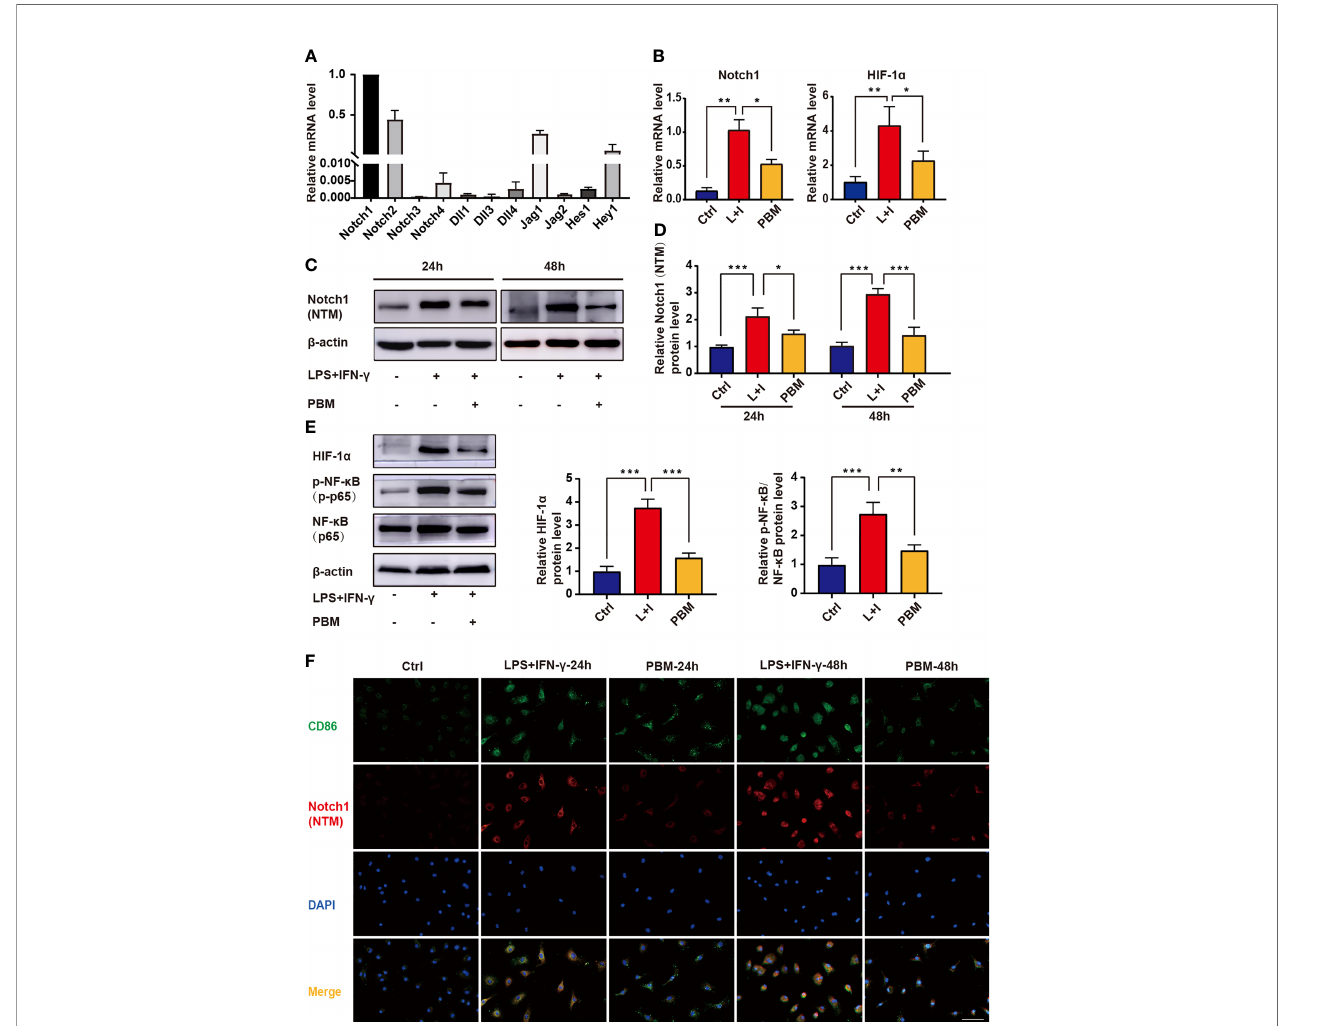
FIGURE 6 | Effect of PBM on the Notch1-HIF-1 a /NF- k B signalling pathway in M1 macrophages. (A) The mRNA expression levels of Notch signalling pathway- related genes were detected in BMDMs by RT – PCR (n = 3 per group). (B) The mRNA expression levels of Notch1 and HIF-1 a were detected by RT – PCR in macrophages in the control (Ctrl), L+I (LPS + IFN- g ), and PBM (LPS + IFN- g + PBM) groups (n = 3 per group). (C, D) Protein levels of the cleaved transmembrane/ intracellular region of Notch1 (NTM) in the indicated groups were determined by western blotting 24 and 48 hours after the fi rst PBM intervention (n = 3 per group at each time point). (E) Protein levels of HIF-1 a , NF- k B and p-NF- k B were detected by western blotting of macrophages in the control (Ctrl), L+I (LPS + IFN- g ) and PBM (LPS + IFN- g + PBM) groups (n = 3 per group). (F) Immuno fl uorescence of Notch-1 (red) and CD86 (M1 macrophage marker; green) in macrophages from different treatment groups (n = 3 per group). *P < 0.05, **P < 0.01, ***P <